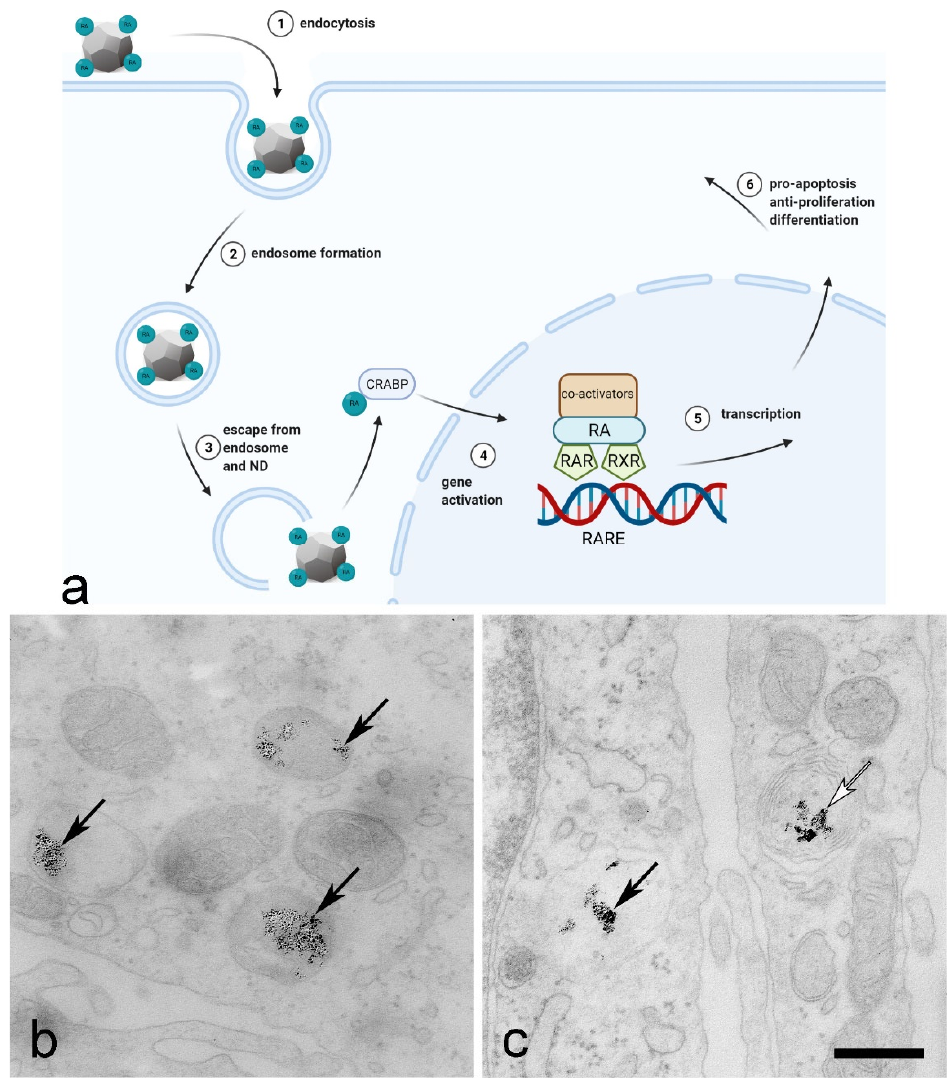
Figure 3. Endocytosis and intracellular pathway of retinoic acid (RA) conjugated to ND. ( a ) After endosome formation in the cell, the crucial step is the release of RA from the endosome and its binding to the cellular retinoic acid-binding protein (CRABP). CRABP transports RA into the nucleus, where it can form large protein complexes consisting of co ‐ activators and the retinoic acid receptor (RAR) and retinoid X receptor (RXR), activating RA response elements (RARE). ( b , c ) Internalisation assay performed with two human cell lines: non ‐ invasive papillary urothelial cancer cells RT4 ( b ) and invasive urothelial cancer cells T24 ( c ). For both cell lines, DNDs were added to the culture medium at a concentration of 11 μ g/mL for 24 h and cells were prepared for transmission electron microscopy. DNDs were observed in endocytotic compartments (black arrows; ( b , c )) and in multilamellar bodies (white arrow; c ). A detailed analysis of the endocytosis of DNDs is published in [5]. Scale bars: 500 nm. The illustration was created by the authors using the BioRender app and our own TEM images.